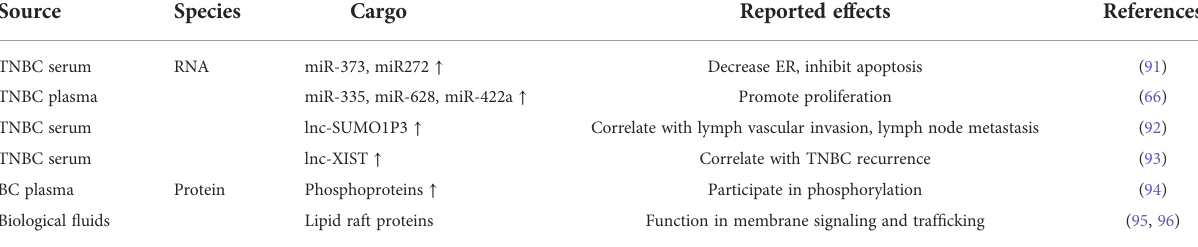
TABLE 2 sEV contents as biomarkers for BC and